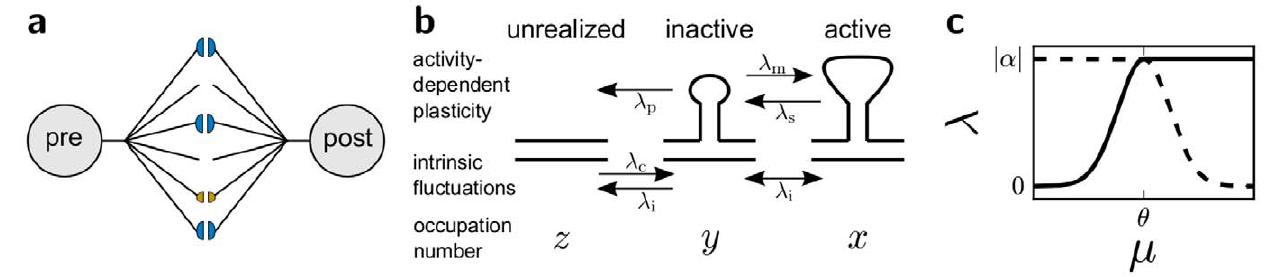
Figure 1. Illustrations. a : Schematic of a synapse connecting a pair of cortical neurons (pre- and postsynaptic). Individual synaptic contacts can be active (blue, larger; corresponding to a large dendritic spine), inactive (orange, smaller; corresponding to a thin dendritic spine) or unrealized. b : State diagram of the structural plasticity model adapted from [22]. A synaptic contact can occupy one of three states: active, inactive or unrealized. Transitions from one state to the other are possible through either intrinsic fluctuations or activity-dependent plasticity, indicated by the arrows. The transitions from unrealized to inactive are called ‘‘creation’’ (rate l c ), from inactive to active ‘‘maturation’’ (rates l m and l i ). The transitions from active to inactive are called ‘‘shrinkage’’ (rates l s and l i ) and from inactive to unrealized ‘‘pruning’’ (rates l p and l i ). A synapse consists of N close appositions which may or may not host inactive or active synaptic contacts. The occupation number of the three states, active, inactive, unrealized are called x , y and z , respectively. c : Assumed functional form of the dependence of the rate of activity dependent transitions ( l m , l s , l p ) on the mean value m of the correlation trace, which is formed at the dendritic spine. The absolute value of a sets the scale of the transition rate, while its sign flips the function from right-saturating (solid) to left-saturating (dashed). The parameter h determines at what correlation level saturation of the transition rate is reached.